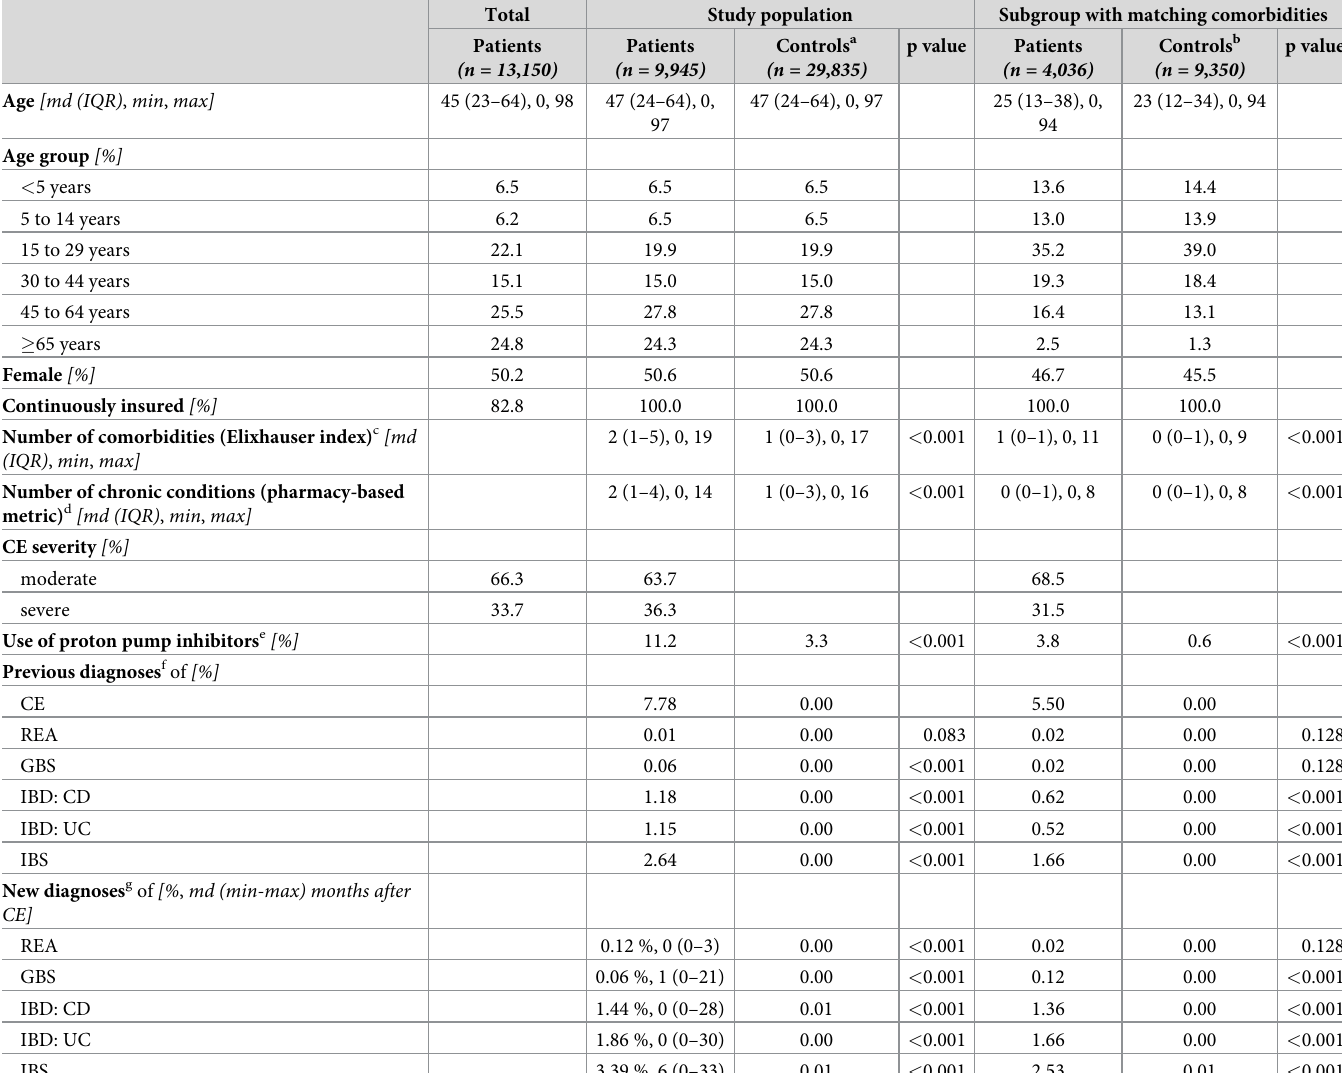
Table 1. Baseline characteristics (in